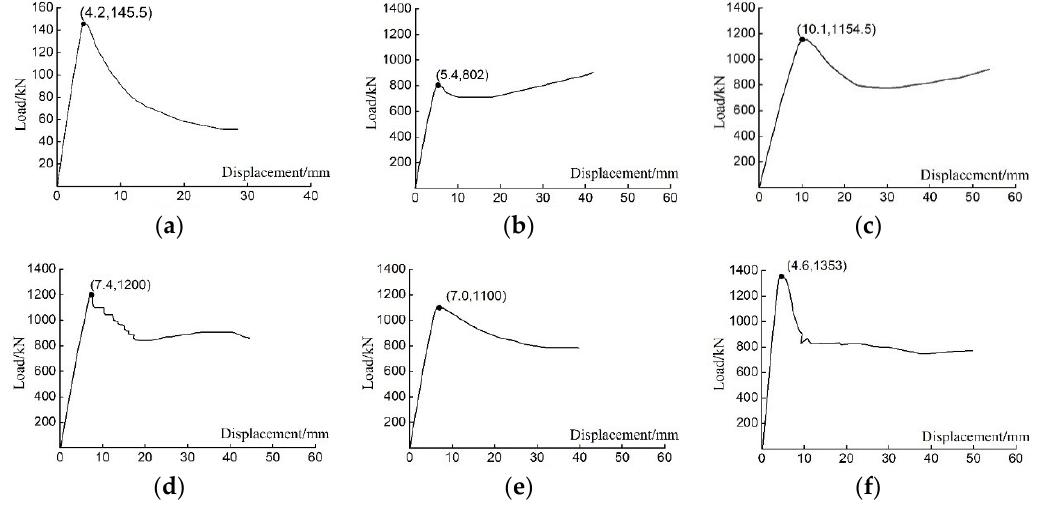
Figure 6. Load–displacement relationship curves of column specimens. ( a ) C1; ( b ) C2; ( c ) C3; ( d ) C4; ( e ) C5; ( f )